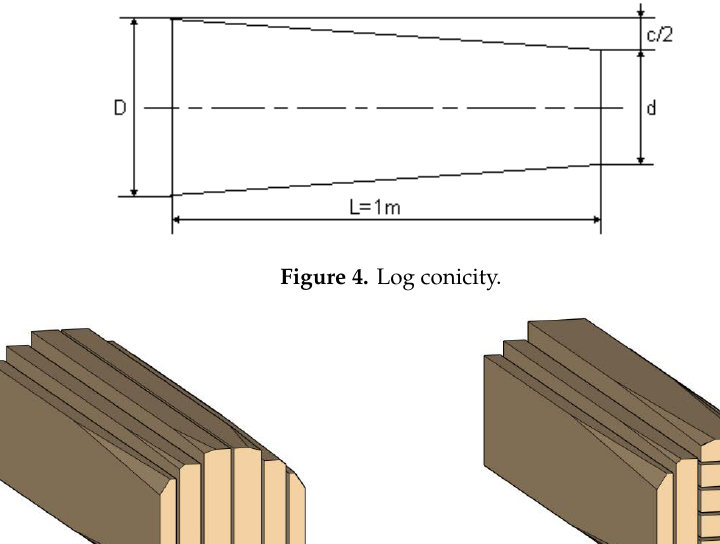
Figure 3. Cut thickness.